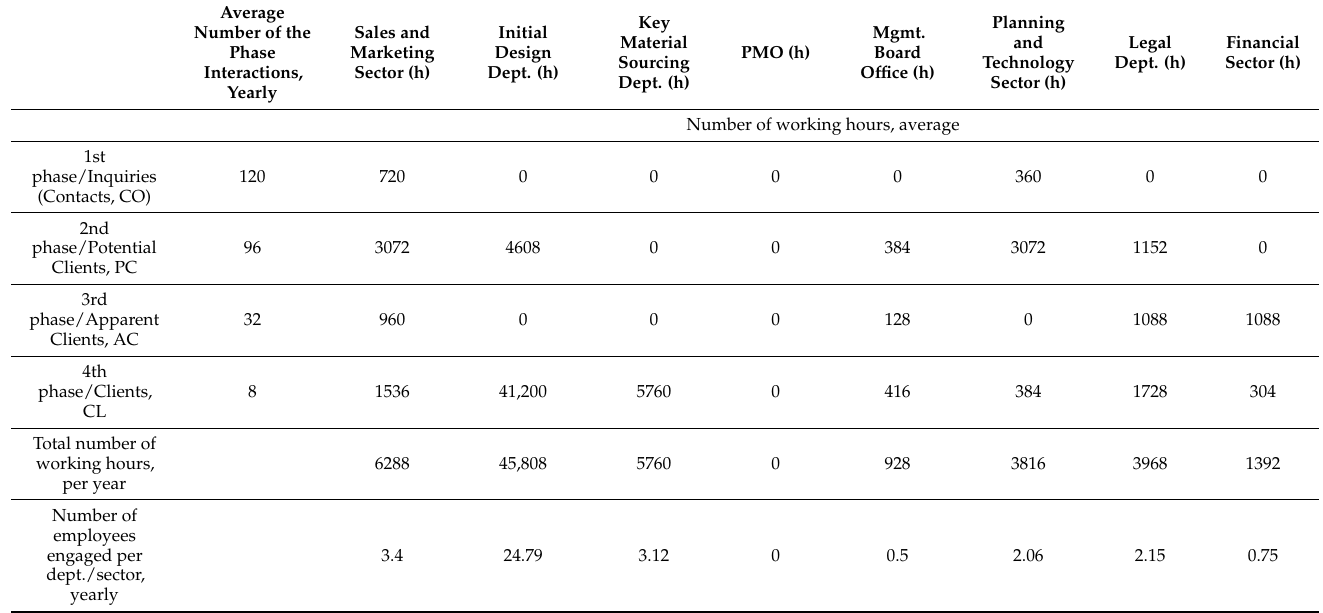
Table 1. The necessary number of employees in the sales process—annual average—existing